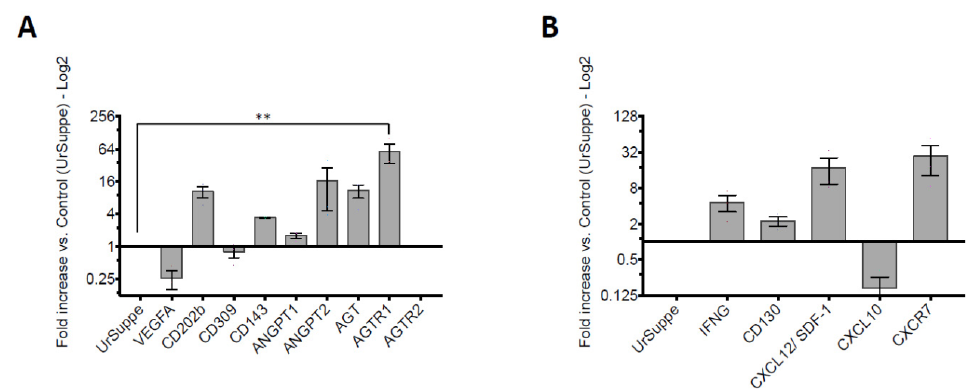
Figure 7. Human ASCs were cultured for 5 days in US-24 with SAG and Insulin medium, and then the mRNA expression levels of the 14 genes indicated on the x -axes were measured by RT-qPCR. Each gene’s normalized expression ratio was correlated to the corresponding value obtained with the hASCs grown in UrSuppe medium ( n = 3, error bars represent S.E.M., p value; **: p value < 0.01). ( A ) Angiogenesis genes; ( B ) Cytokines and chemokines genes. AGTR2 is not expressed; mRNA not